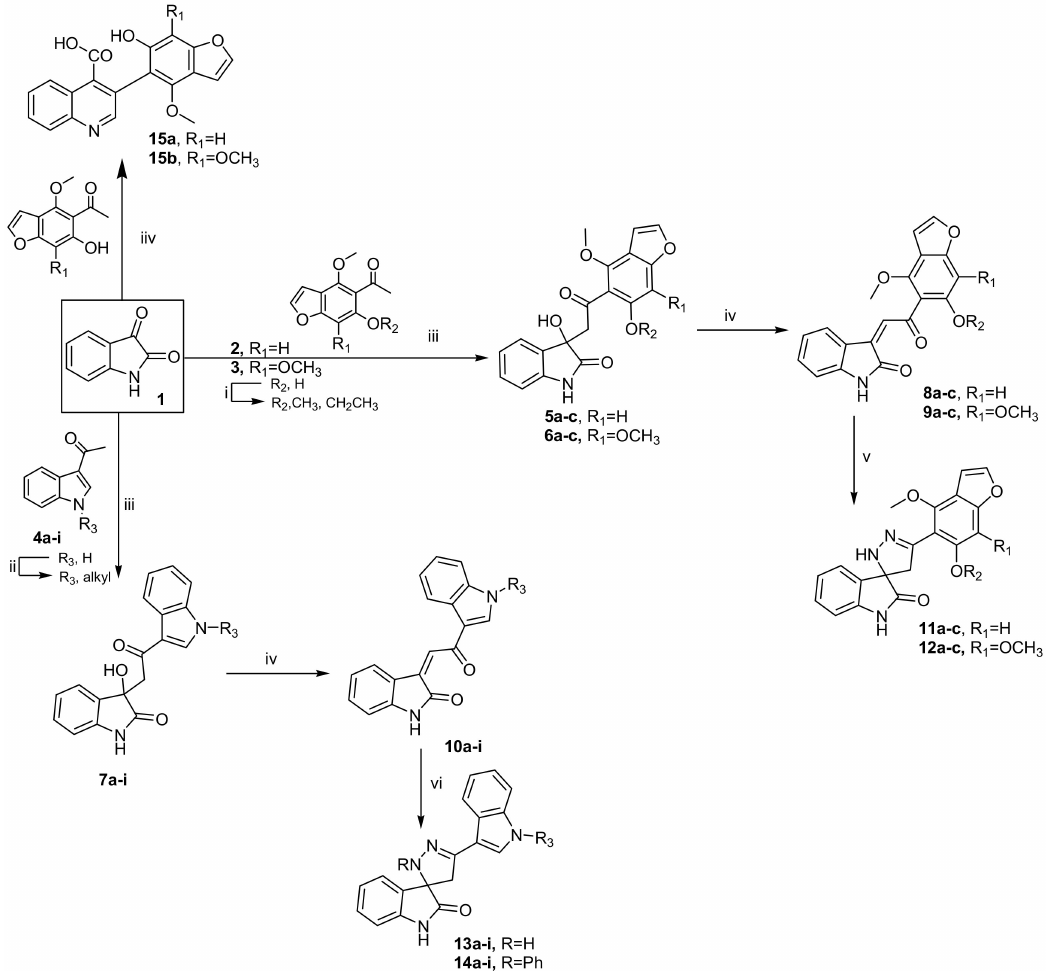
Figure 1. Reagents and conditions: ( i ) alkyl halide, acetone, K 2 CO 3 , reflux; ( ii ) alkyl halide, DMSO, NaOH, stirring, r.t.; ( iii ) EtOH, diethylamine, stirring, r.t. 10–15 days (Method A); EtOH, diethylamine, reflux, ~ 5h (Method B); ( iv ) gl. AcOH, HCl (2 drops), 80 ◦ C, 30 min; ( v ) N 2 H 4 .H 2 O (98%), EtOH, gl. AcOH (2 drops); ( vi ) N 2 H 4 .H 2 O (98%) or NH 2 NHPh, EtOH, gl.AcOH (2 drops), reflux and ( vii ) EtOH, KOH (33%),